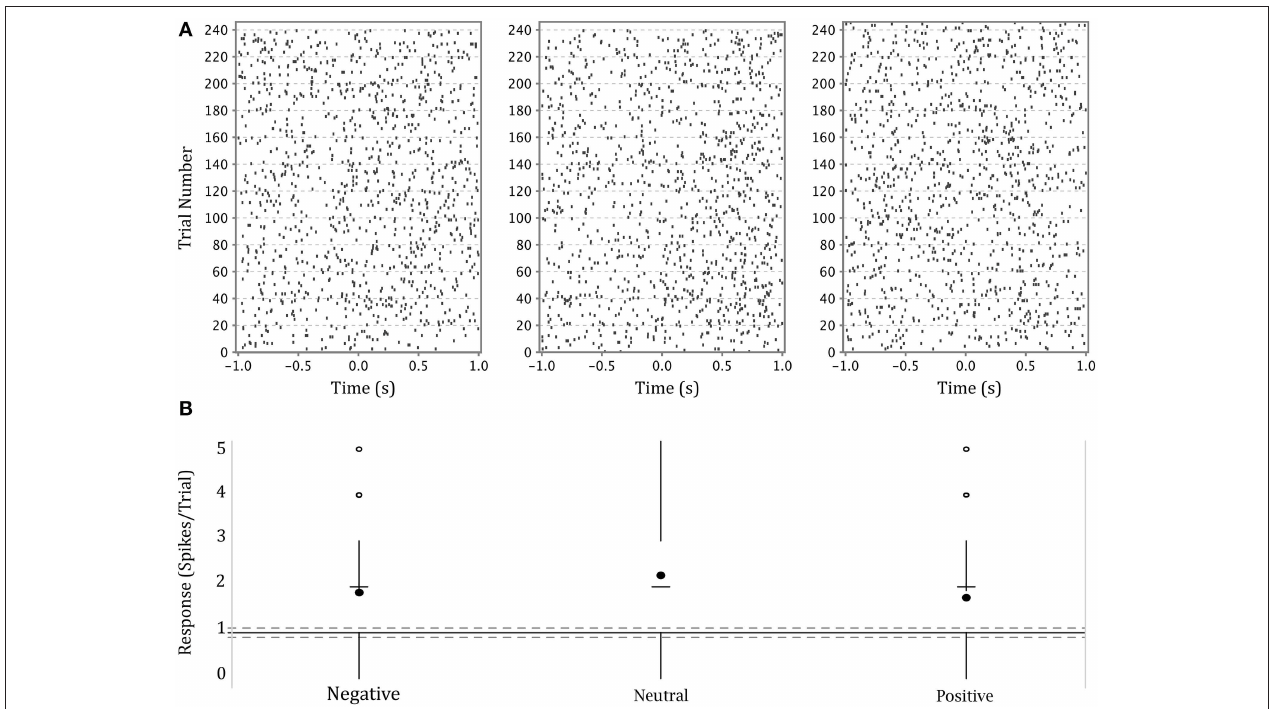
FIGURE 4 | (A) Upper panel: raster plots of the responses of a single neuron in the left amygdala of a male participant to each of three categories of affect. Y axis—trial numbers. The points on each line represent the firing of action potentials during each trial. X axis—time in seconds from onset of stimulus. The rasters are specific to the affect categories labeled at the base of part B. (B) Lower panel: Modified box-plot of the firing rate of the same neuron in the left amygdala of a male participant as a function of stimulus affect. The center dots show mean response per affect category. The horizontal dashes show median response per affect category. Vertical lines extend from ± ( 1 . 58* IQR ) (where IQR interquartile range, n number of observations; equivalent to a 95% confidence interval for differences √ ( n ) = = beyond the first or third quartiles. Open between medians, Chambers et al., 1983, p. 62) to the data point furthest from the median which is no more than 1 . 5* IQR (cid:1) ± (cid:0) circles show responses outside that range. Solid gray line shows the mean of background firing; dashed gray lines at ± ( 1 . 58* IQR ) of the background firing q(cid:0) ˆ n (cid:1) ( n mean number of presentations of an object ), representing a 95% confidence interval for the median of background firing. ˆ =